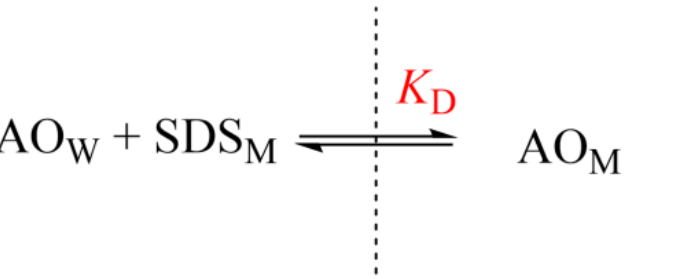
Figure 5. Representation of the association process of antioxidants to micellar aggregates. AO W stands for the antioxidant present in the water phase, AO M stands for that in the micellar phase, and SDS M stands for the micellized surfactant.